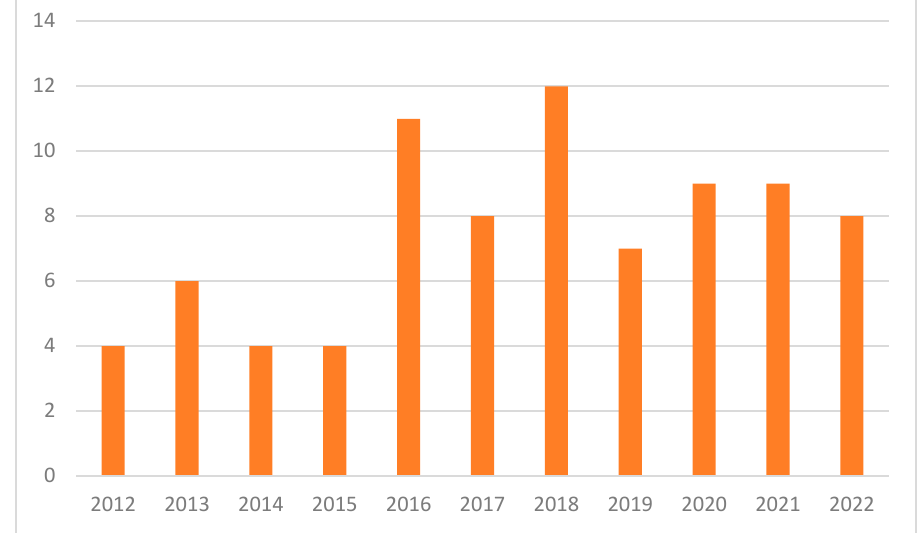
Figure 6. Number of studies year-wise.